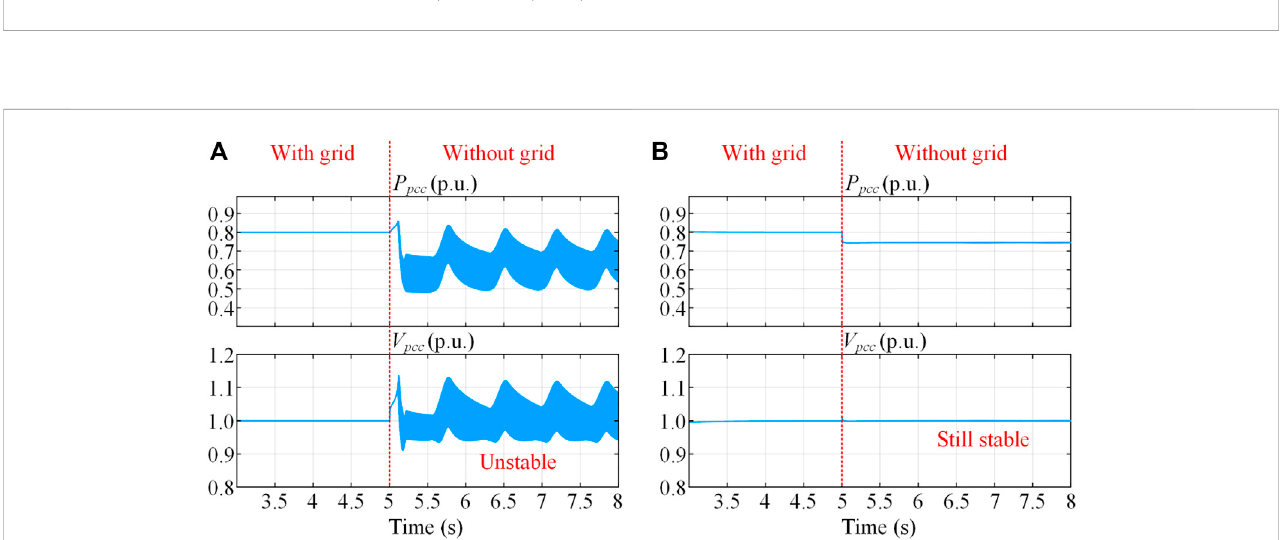
FIGURE 4 Simulation results of a grid-connected converter with different control schemes. (A) With grid-following control; (B) With grid-forming